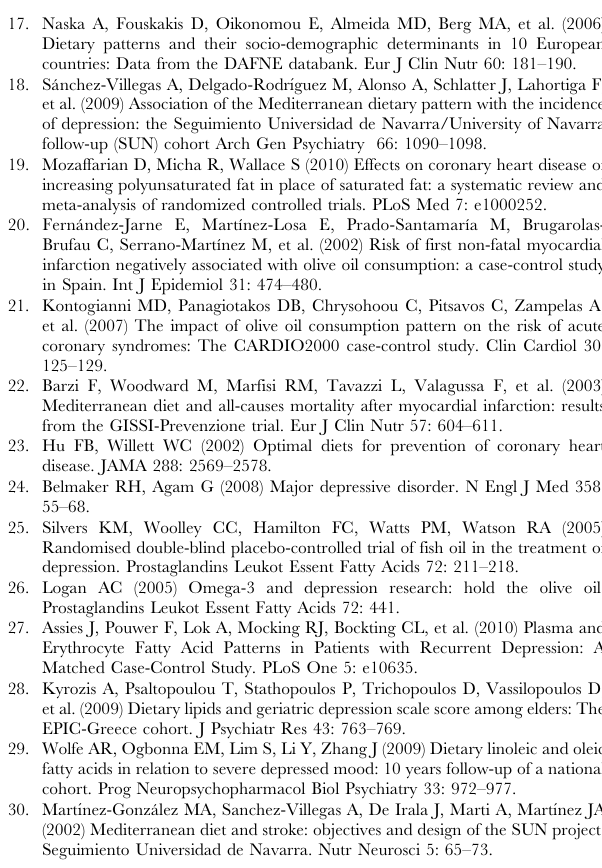
Table S1 MDP: Mediterranean Dietary Pattern. * Hazard ratios estimated with Cox Regression and 95% confidence interval (95% CI) If the confidence interval does not include 1.00, the results are statistically significant (two-tailed p , 0.05). { energy adjusted median intake and percentage of total energy intake. { Crude rates and 95% confidence intervals. (1) Model 1: adjusted for: sex, age (years), smoking (non, former, current smoker and missing value), leisure time physical activity (in quintiles of MET score), total energy intake (Kcal/day), and BMI (Kg/m 2 ). (2) Model 2: Model 1 additionally adjusted for adherence to the Mediterranean Dietary Pattern (excluding SFA/MUFA